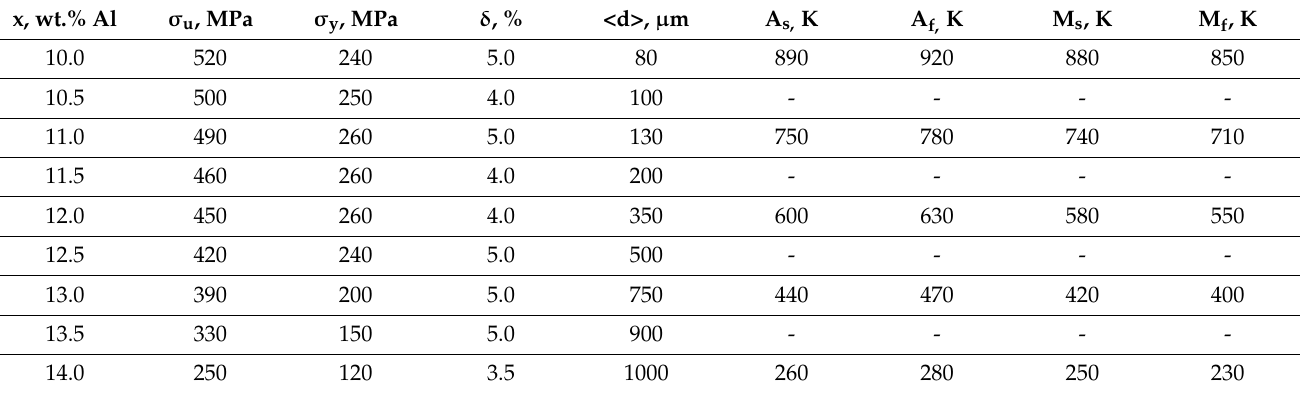
Table 2. Mechanical properties of Cu-xAl -4.5 wt.%Ni alloys. Treatment